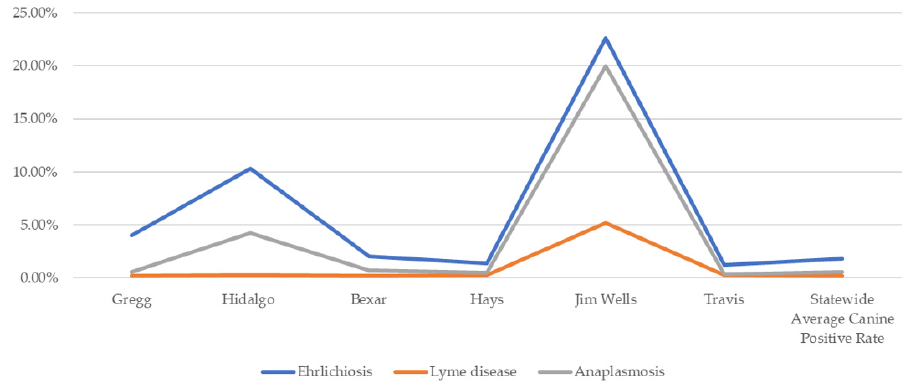
Figure 6. Percent of canines testing positive by TBD in selected counties (2020) [19]. Human LD cases are noted in Figure 7. Red dots on selected counties indicate locations where survey respondents presented with the most severe symptoms.